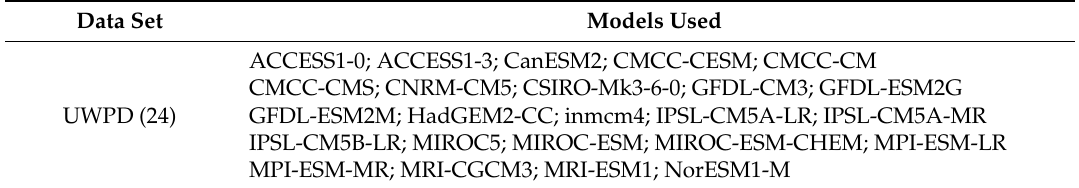
Table 1. Intergovernmental Panel on Climate Change (IPCC) models used to generate the downscale data